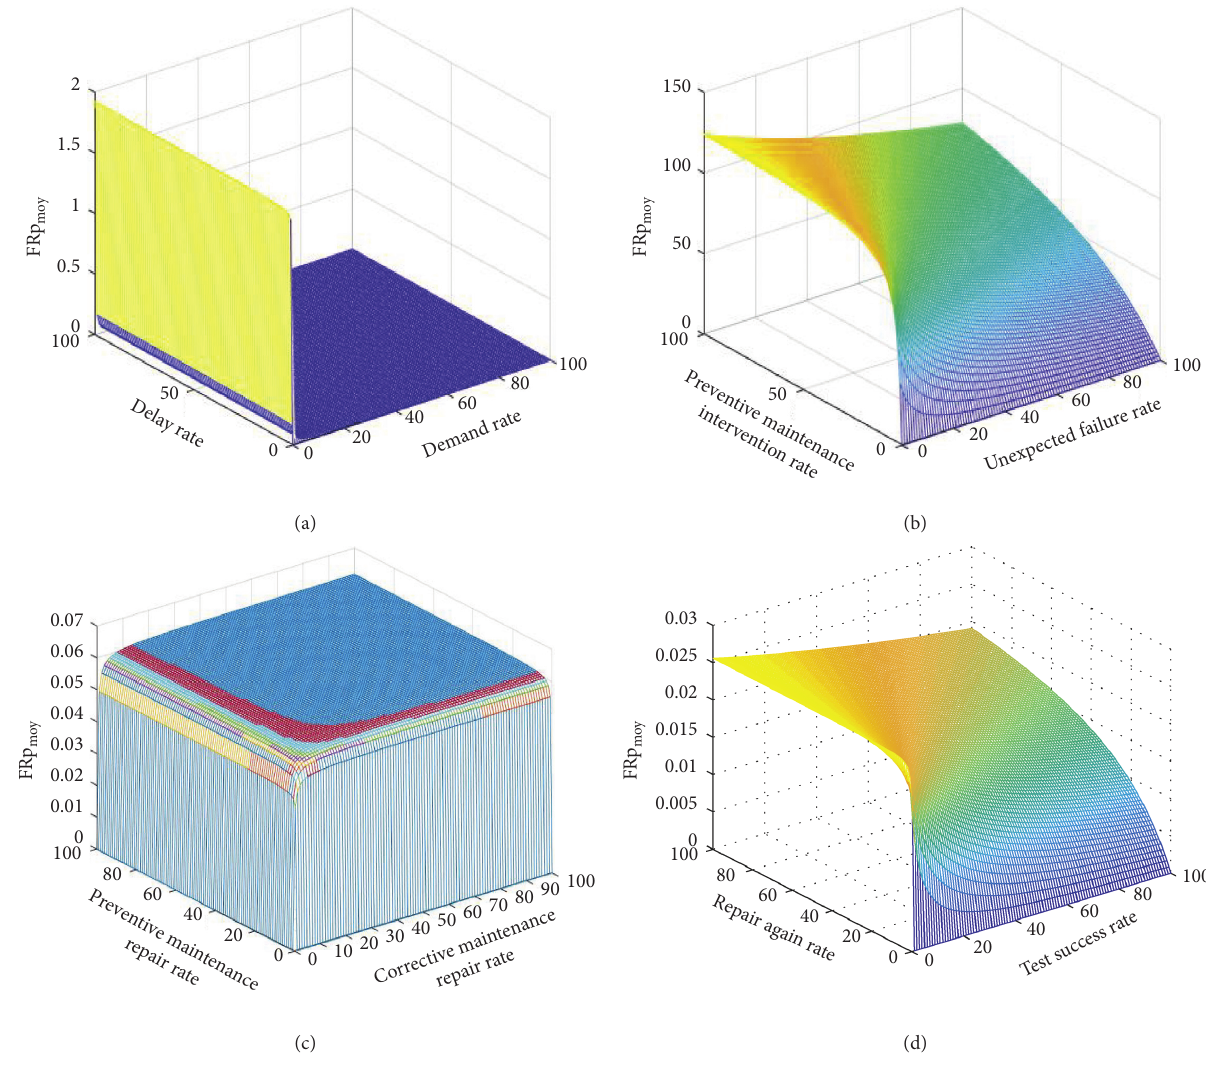
Figure 11: Preventive repair frequency. (a) Variation of demand and delay rates. (b) Rate variation of unexpected failure and maintenance interventions. (c) Repair rate variation for corrective and preventive maintenance. (d) Test rate variation (repair again or